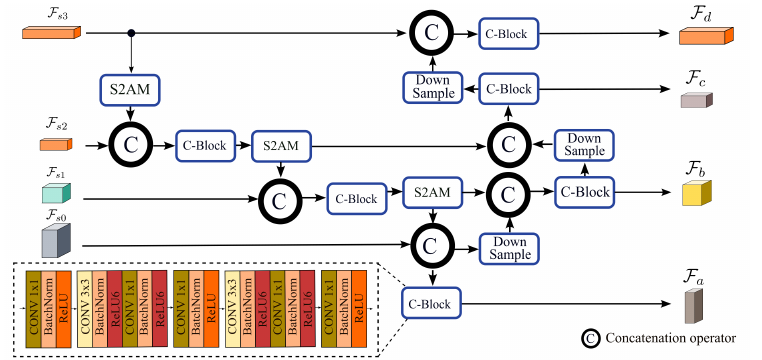
Figure 7. The layout of the AESF module.